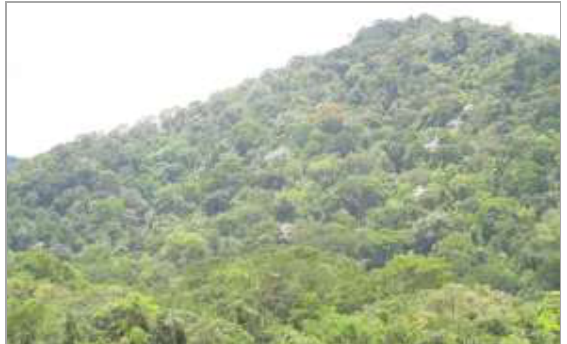
Figure 5. Types of vegetation – Forest Conservation Internship in Secondary